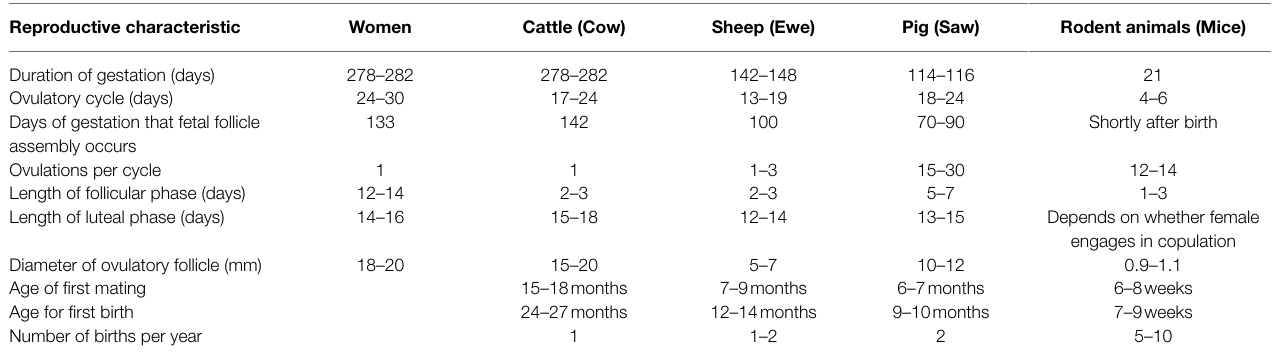
TABLE 1 | Summary of reproductive characteristics and life cycle of humans, cattle, sheep, and rodents. 1